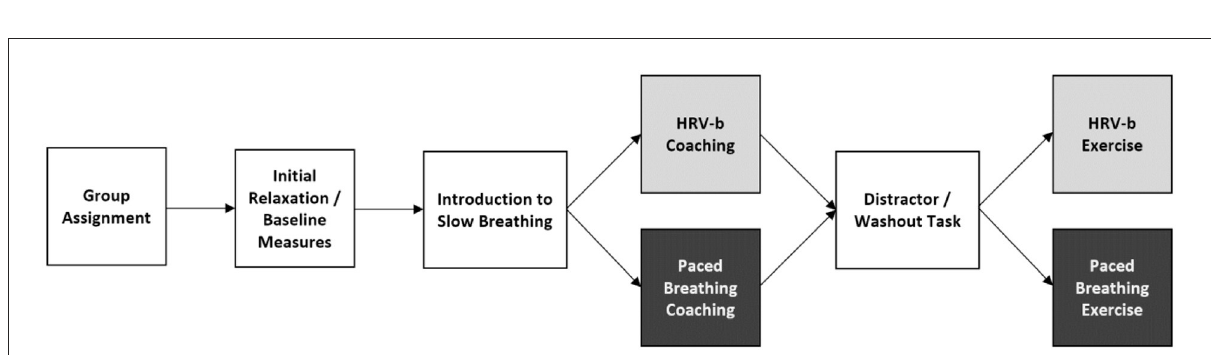
FIGURE4 A block diagram summarizing the experiment procedure. White blocks were completed by all participants. Gray blocks were completed by participants assigned to the HRV-b exercise protocol condition, whereas black blocks were completed by those in the Paced Breathing